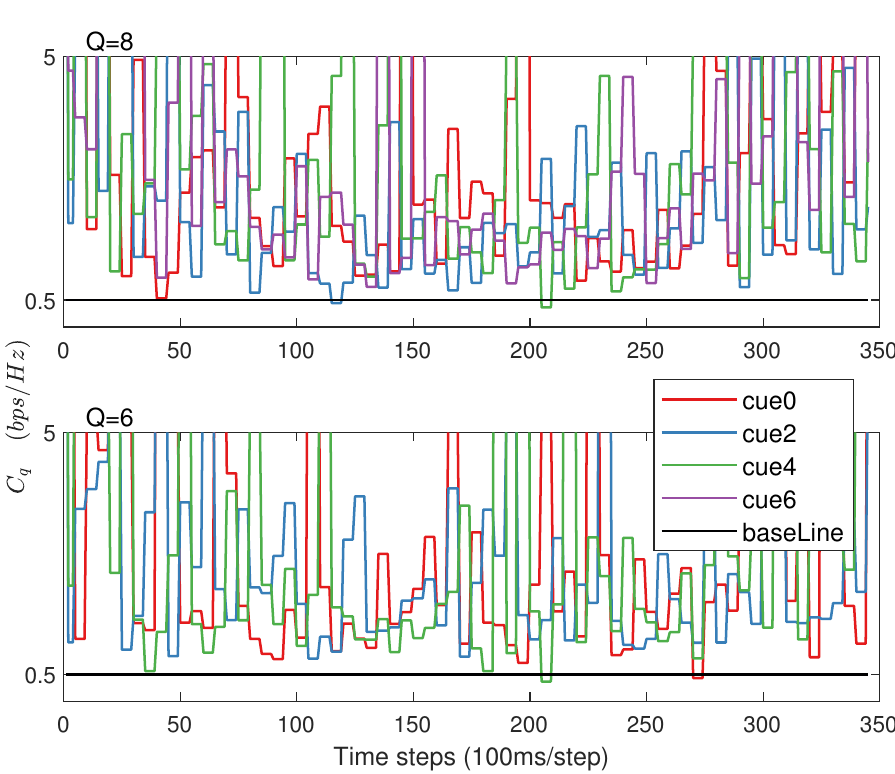
Figure 9. The ergodic capacities of CUEs when the resource allocation period is 500 ms.